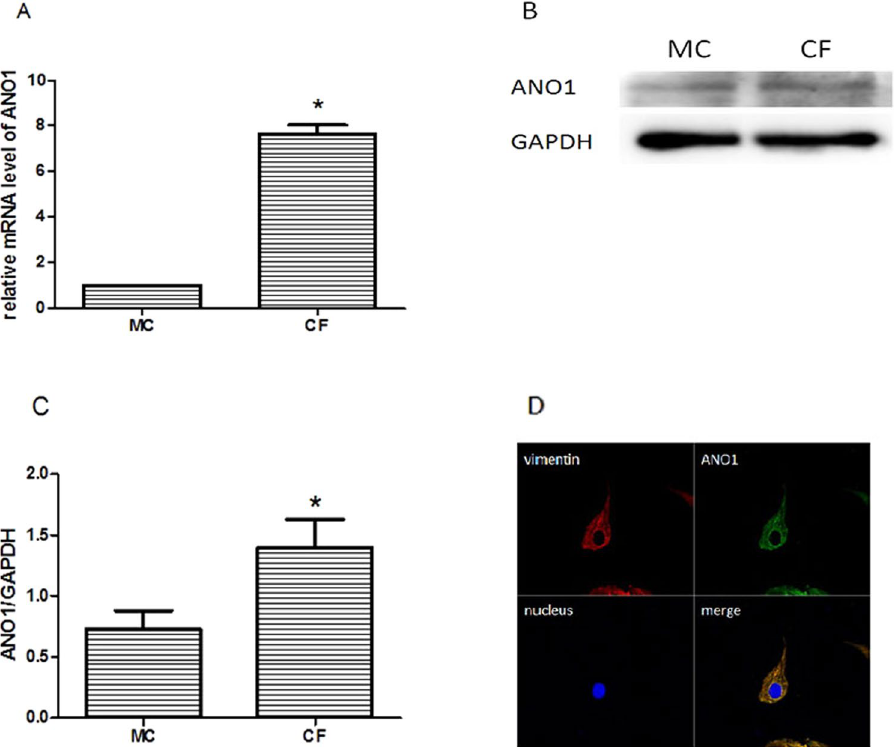
Figure 1. Expression of ANO1 in myocardial cell and cardiac fibroblasts by qRT-PCR ( A ), western bloting ( B , C ), and immunofluorescent confocal microscopic analysis ( D ). ( A ) qRT-PCR showed the relative mRNA level of Ano1 in myocardial cell and cardiac fibroblasts. ( B , C ) Western blotting demonstrated the expression of ANO1 protein in myocardial cell and cardiac fibroblasts. ( D ) Immunoflurescent confocal microscopy showed ANO1 protein expression profiles, cardiac fibroblasts were identified by vitemtin staining (red), ANO1 protein was green staining, and nuclei were identified by DAPI staining (blue). MC as myocardial cell, CF as cardiac fibroblasts. * p < 0.05, ** p <